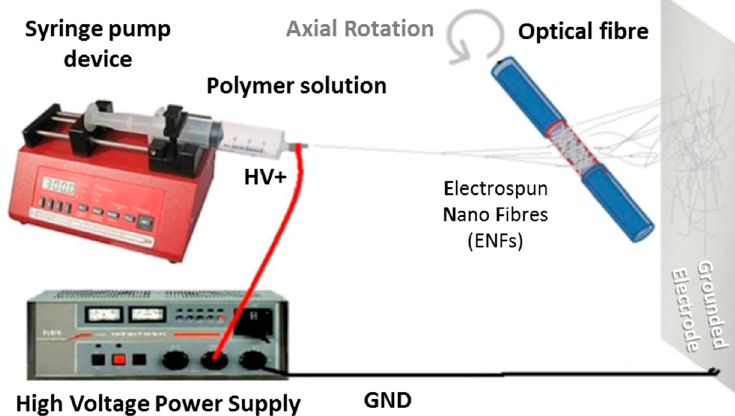
Figure 13. Set up for an electrospinning deposition onto an optical fibre. The main relevant elements are the syringe pump device, the high voltage source and the grounded electrode. Reprinted from [37] with permission from Elsevier.